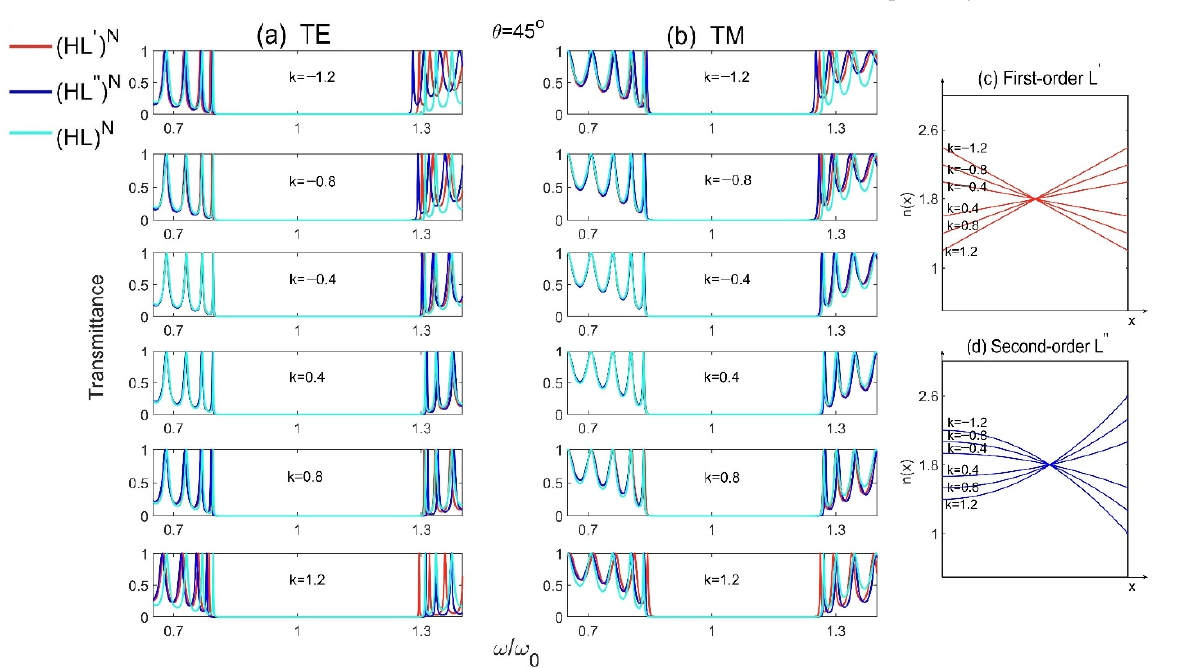
Figure 8. The transmission spectra of Model 3 ( HL (cid:48) ) N , Model 4 ( HL (cid:48)(cid:48) ) N and the reference Model ( HL ) N for different slopes k at incident angle θ = 45 ◦ for ( a ) TE and ( b ) TM polarizations, and ( c , d ) are the distributions of refractive index for different slopes k for the first- and second-order gradient material L (cid:48) and L (cid:48)(cid:48) , respectively.